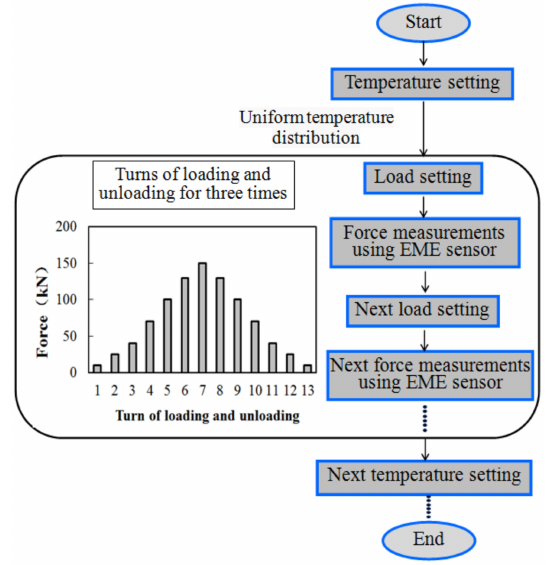
Figure 3. Diagram of the experimental procedure.